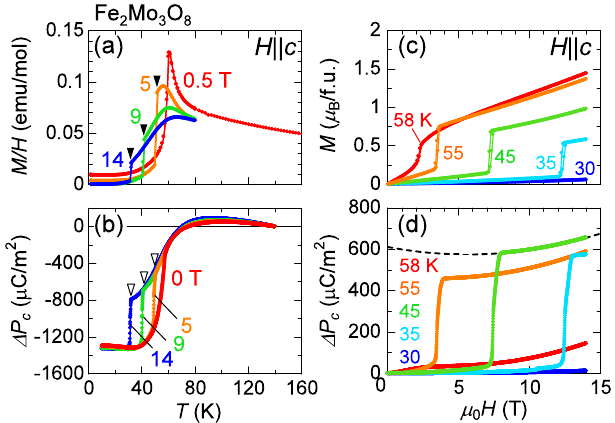
FIG. 2. (a, b) T dependence of (a) M=H and (b) change of P ( Δ P ) under various magnitudes of H along the c axis. (c, d) Field dependence of M and Δ P at various T . The dashed curve is the fit to the P - H curve for H > H at 45 K with the function cr P ¼ P 0 þ α 3 H þ β H 2 , where P 0 , α 3 , and β are constants. Zero points of Δ P are taken at (b) T ¼ 140 K and (d) μ 0 H ¼ 0 T.